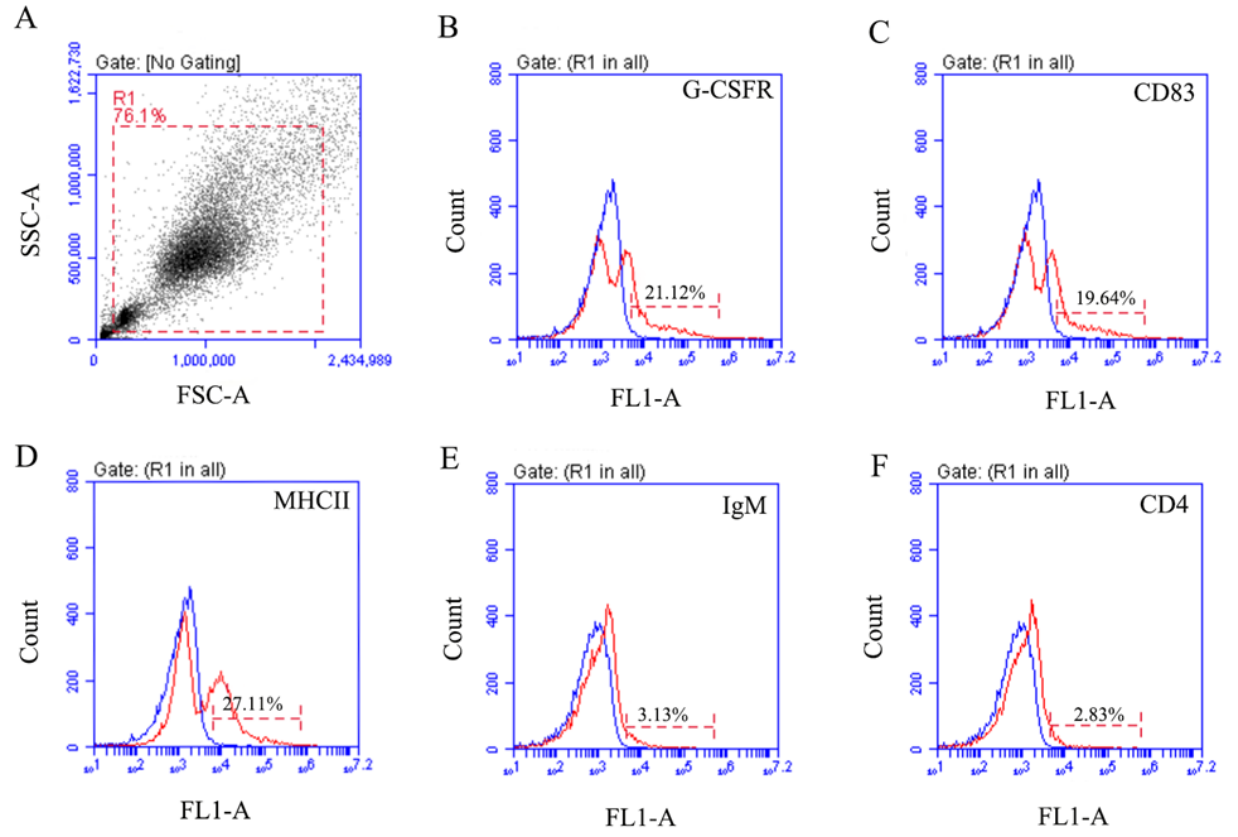
Figure 4. Flow cytometric analysis of the proportions of IgM + , CD4 + , G-CSFR + , MHC Ⅱ + , and CD83 + cells among PerC cells. ( A ). PerC cells gated on a forward scatter (FSC) versus side scatter (SSC) dot plot; ( B – F ): fluorescence histogram of gated peritoneal cells in G-CSFR + , MHC Ⅱ + , CD83 + , IgM + , CD4 + cells.